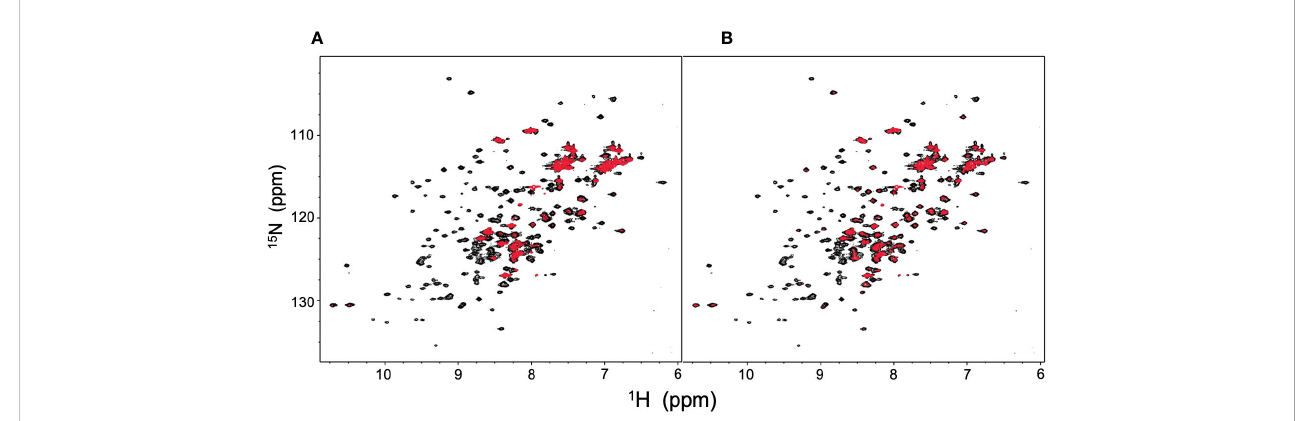
FIGURE 6 HSQC spectral changes of rituximab-Fc induced by human serum and human serum polyclonal IgG. HSQC spectra of uniformly 15 N-labeled rituximab- Fc measured (A) in human serum or (B) in the presence of polyclonal IgG (red) are superposed on the spectrum of rituximab-Fc alone